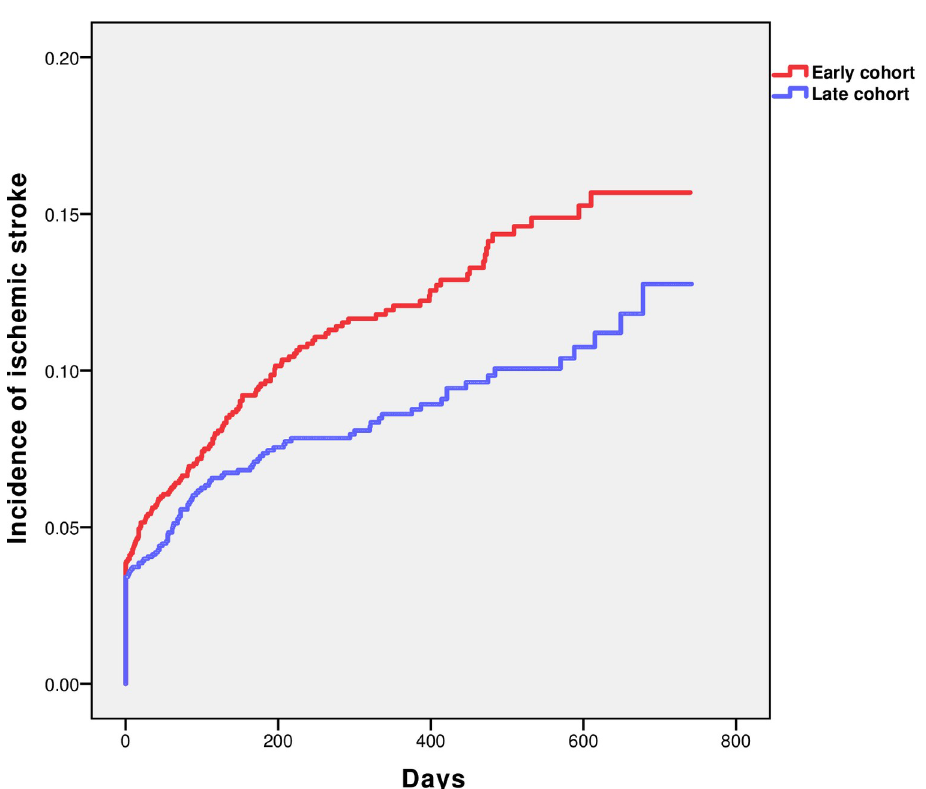
Fig 1. Incidence of ischemic stroke during the study period among patients with AMI with prior ischemic stroke.